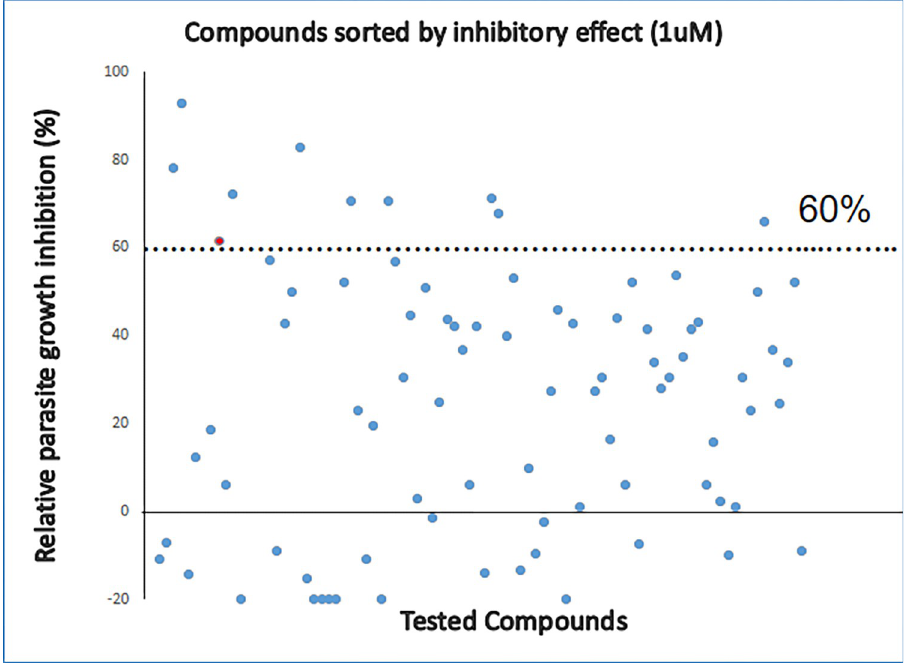
Fig 1. Scatter plot of tested compounds after primary screening at the single concentration of 1 μ M. The growth of C . parvum HNJ-1 strain after exposure to each compound at a single concentration of 1 μ M for 45 h, as determined by means of fluorescence microscopy. The percent inhibition is presented as the percentage of inhibited parasites compared with the positive control (untreated wells) after subtraction of the negative control (uninfected HCT-8 cells). Compounds with a growth reduction of more than 60% (dot line) were considered to be compound that inhibit C . parvum parasite growth. Blue dots represent the compounds and the red dot represents the comparative drug nitazaxonide (10 μ M). This is single experiment with the means of triplicate wells.